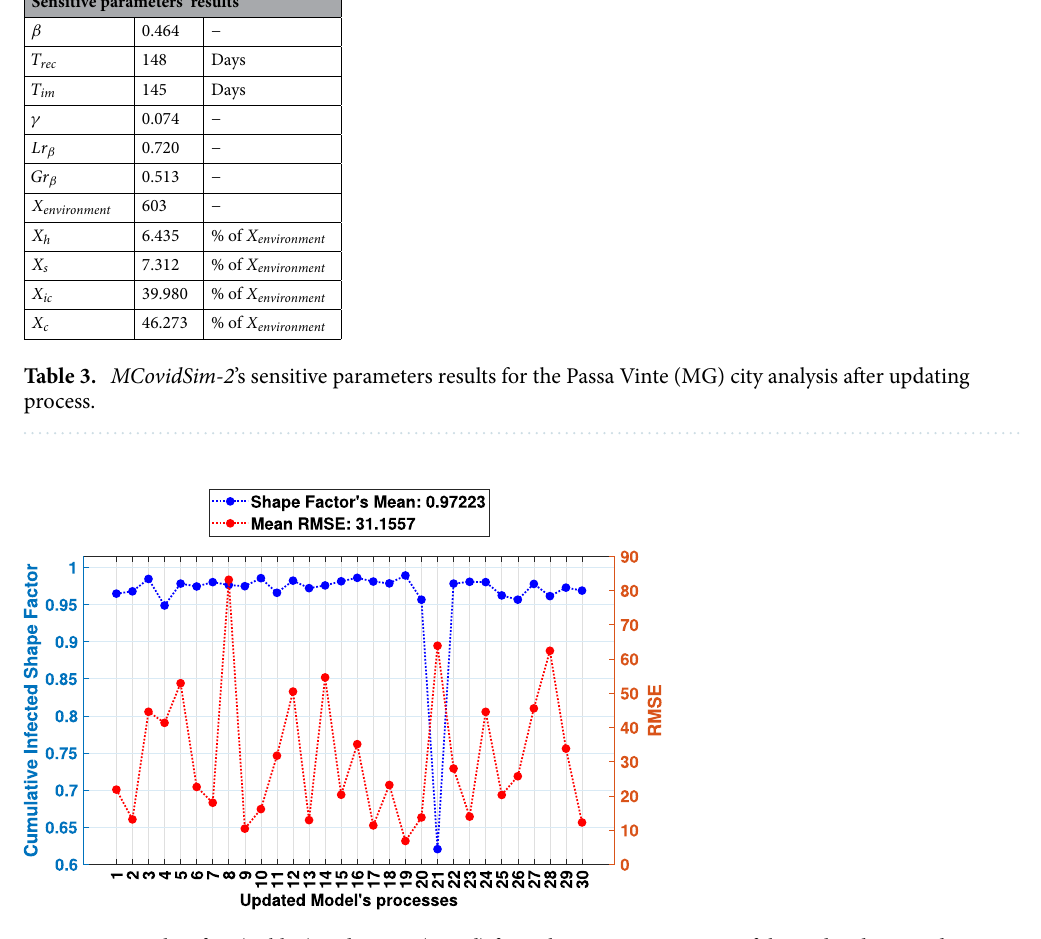
Figure 9. Results of SF (in blue) and RMSE (in red) from thirty times processes of the updated MCovidSim-2